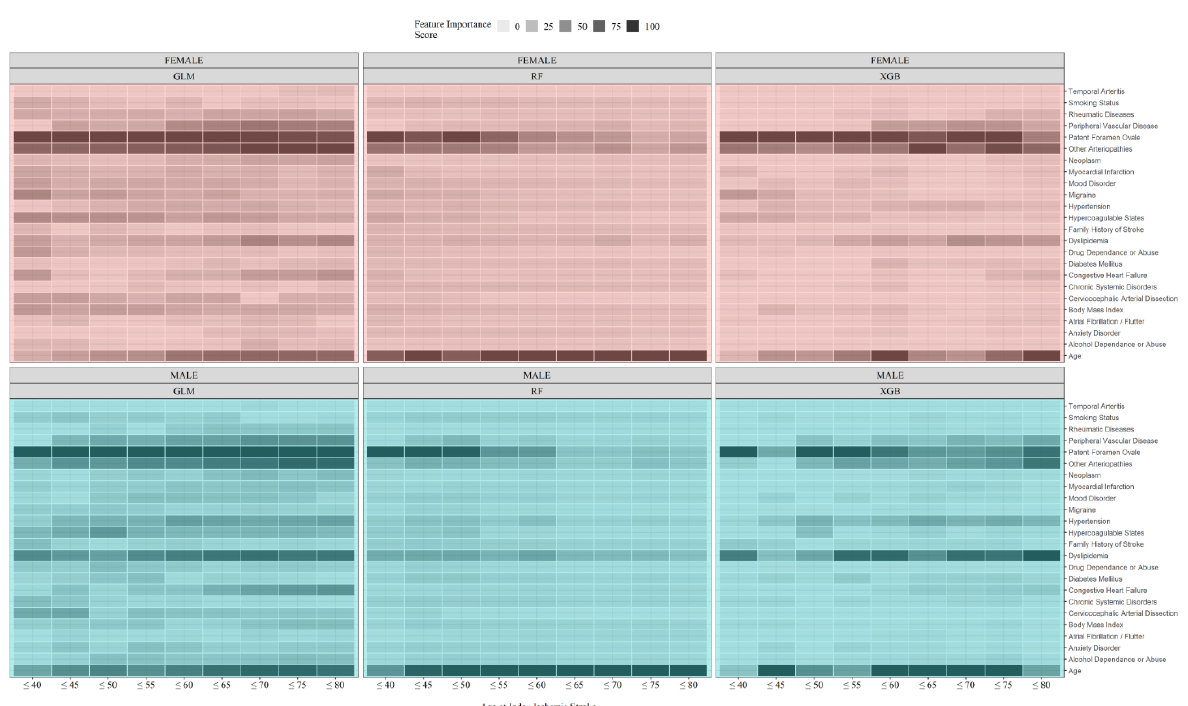
Figure 3. Average feature importance of the variables used by GLM, RF, and XGB models.